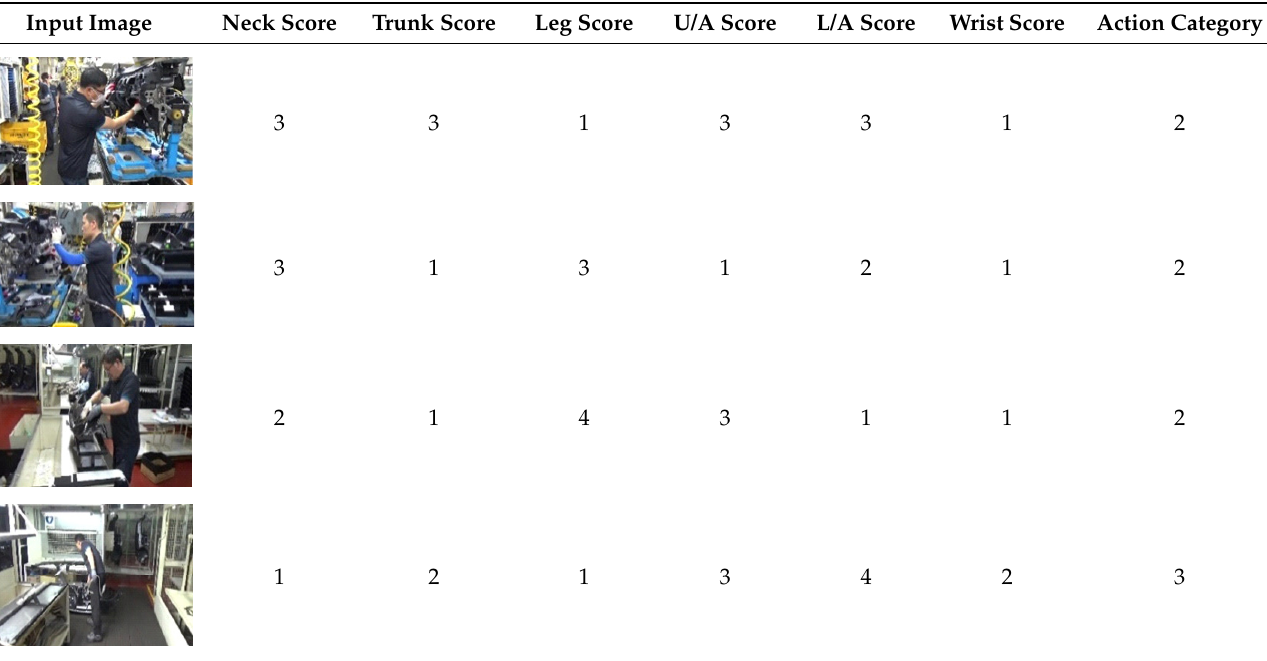
Table 2. Example of REBA score chart for input images. Table 3. Example of RULA score chart for input images.